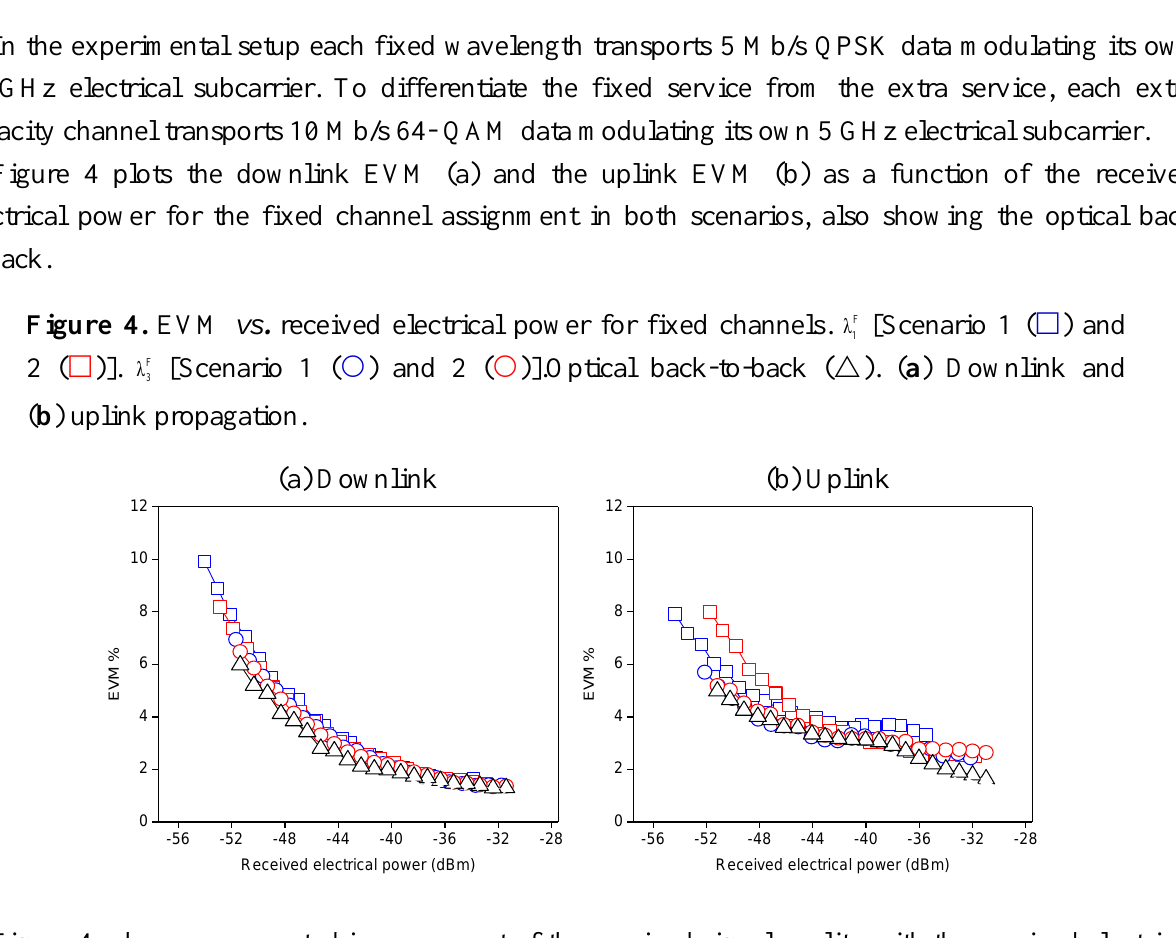
λ [Scenario 1 (  ) and 1